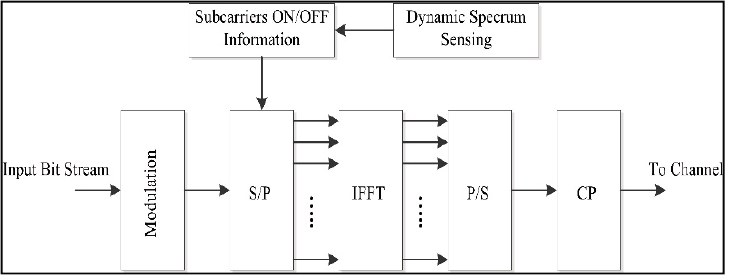
Figure 1. NCOFDM